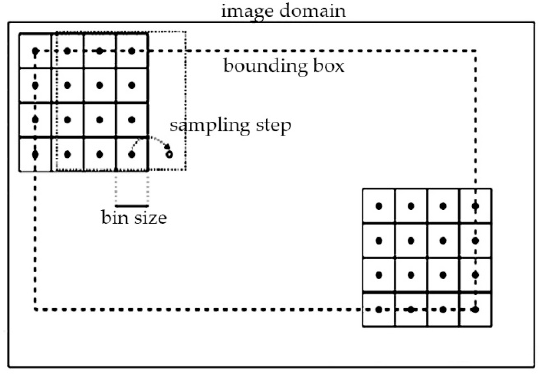
Figure 12. Acquisition of background sampling points. Use a patch of custom size to slide on the image in a certain step.